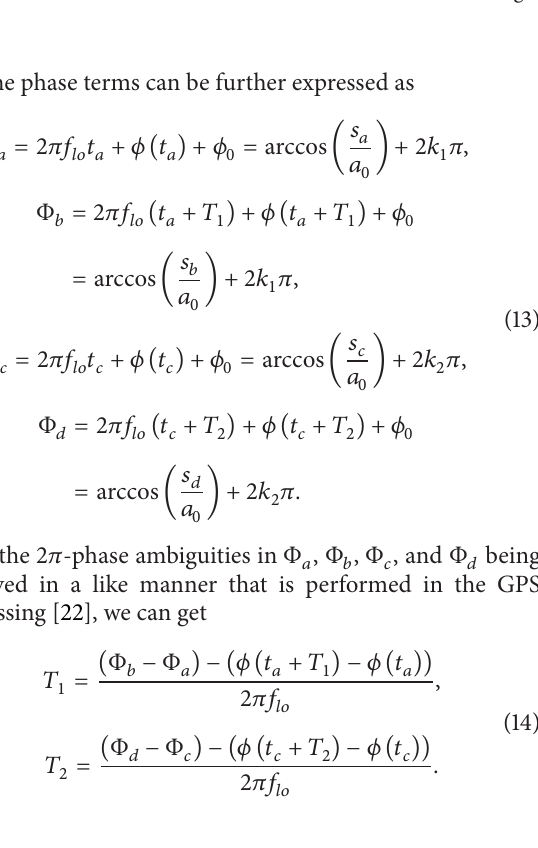
Figure 3: Block diagram of synchronizing